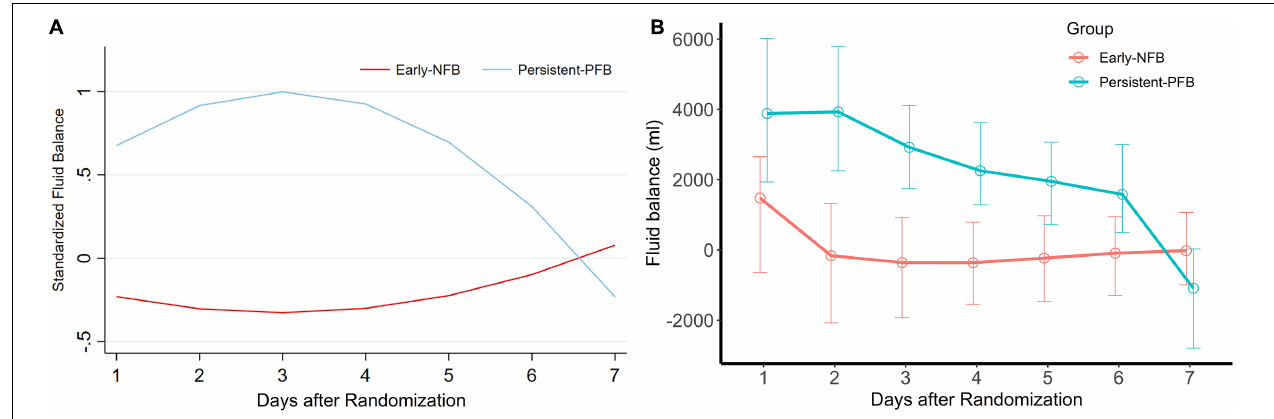
FIGURE 1 | Group-based trajectory model based on the fluid balance trajectories. Using group-based trajectory model, two phenotypes were identified: “Early NFB” and “Persistent-PFB,” Fluid balance were standardized to the mean value of fluid balance (A) . Compare to Early NFB, the fluid balance since the day after randomization were significantly higher in Persistent-PFB (B) . Early NFB, Early Negative fluid balance; Persistent-PFB, Persistent-Positive fluid